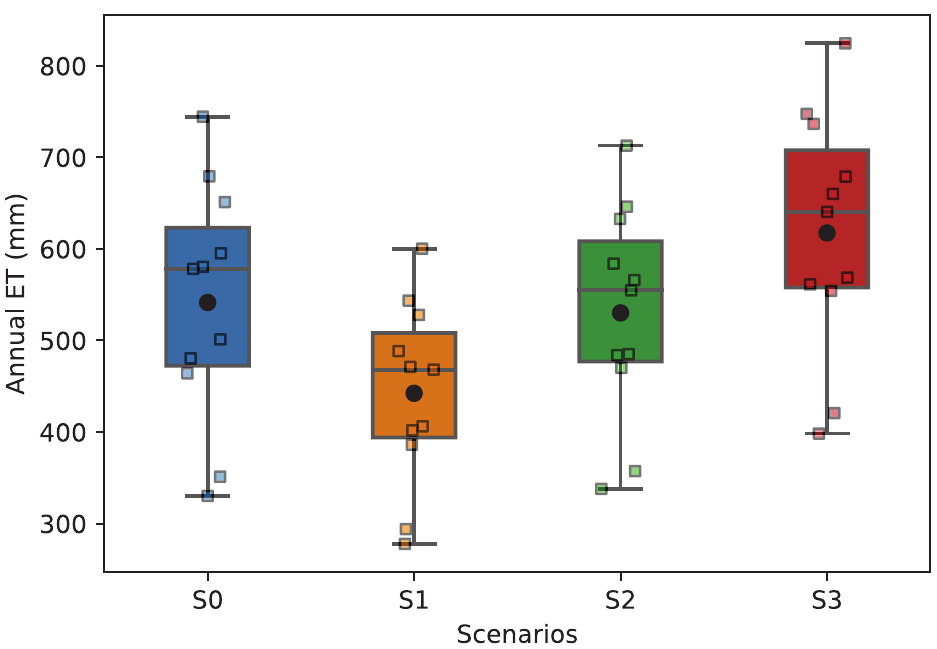
Fig 6. Mean annual evapotranspiration of the study region obtained from model simulations for each climate scenario. Box plots display 25 th , 50 th , and 75 th percentiles. Color squares represent modeled data, and black dots represent the mean value of annual